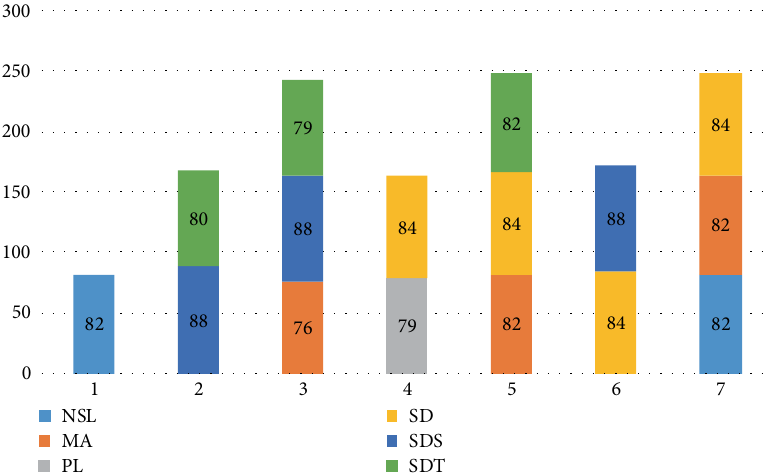
Figure 8: Recommended course groups by CGR